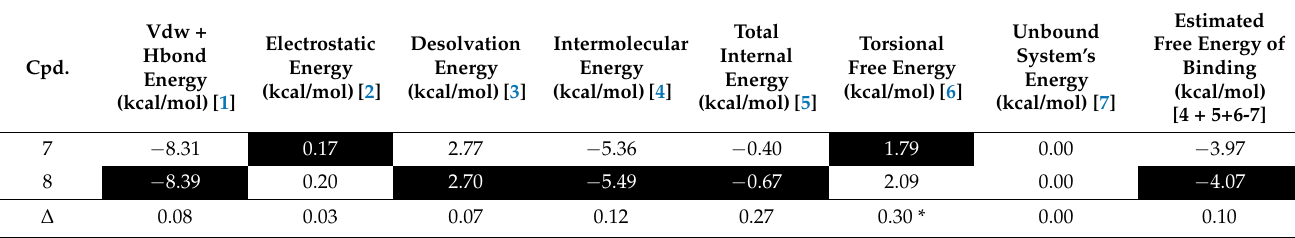
Table 3. Rescoring of the selected docking poses of 4-methyl ether isoliquiritigenin (compound 7) and 3,2’,4’-trihydroxy-4- methoxychalcone (compound 8) using Autodock 4.2.6.